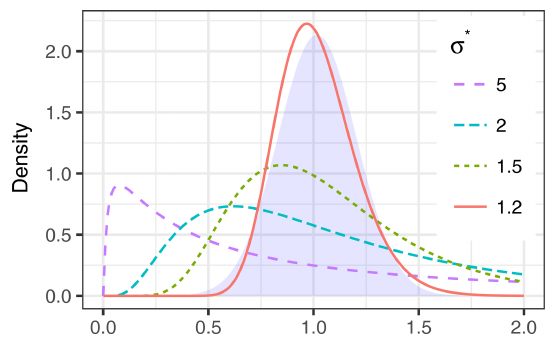
Figure A1. Density distributions of lognormal distributions (lines) get closer to normal density (shaded area) as multiplicative standard deviation σ ∗ decreases down to 1.2 for the same µ ∗ =